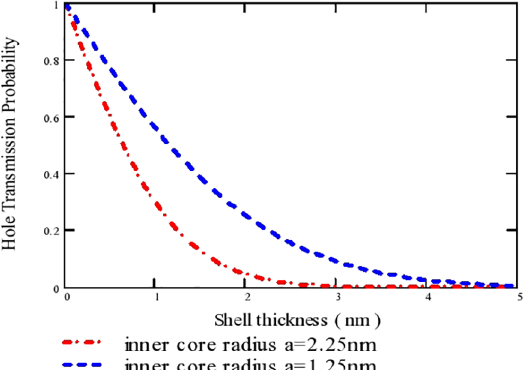
Figure 3. Variation of hole transmission probability as a function of shell thickness in ZnSe/ZnS core-shell quantum dot